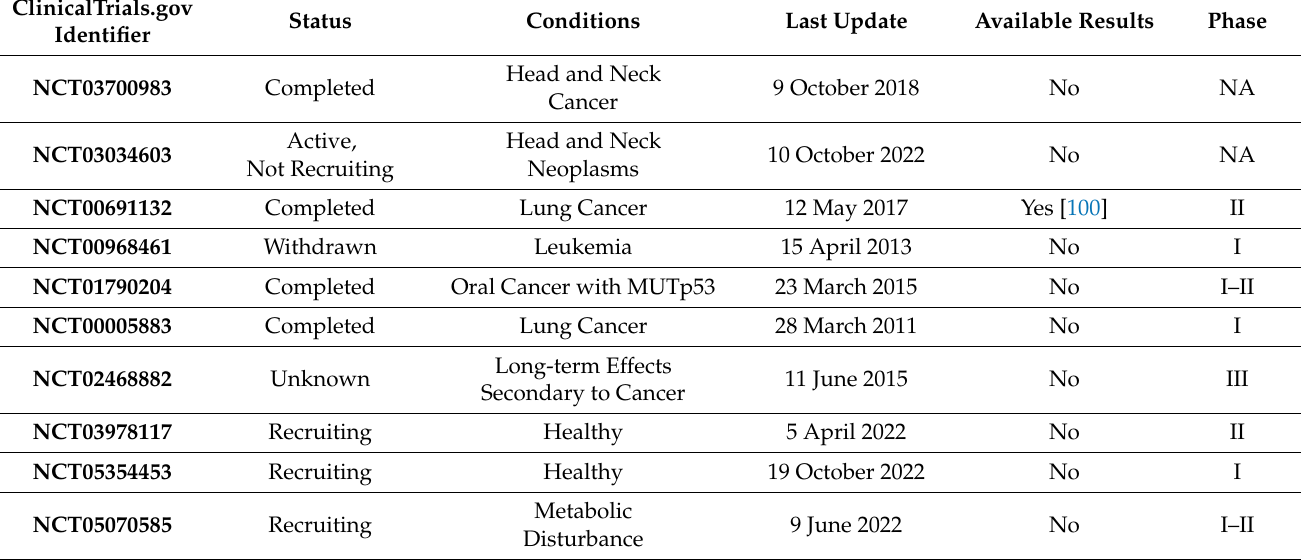
Table 5. Clinical trial for the use of